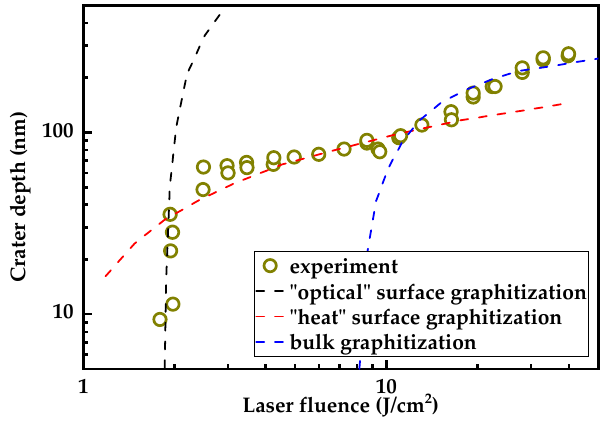
Figure 2. Dependence of ablated crater depth measured after oxidation of graphitized layer on the laser fluence. Curves exemplify different regimes of surface and bulk graphitization induced by femtosecond radiation.